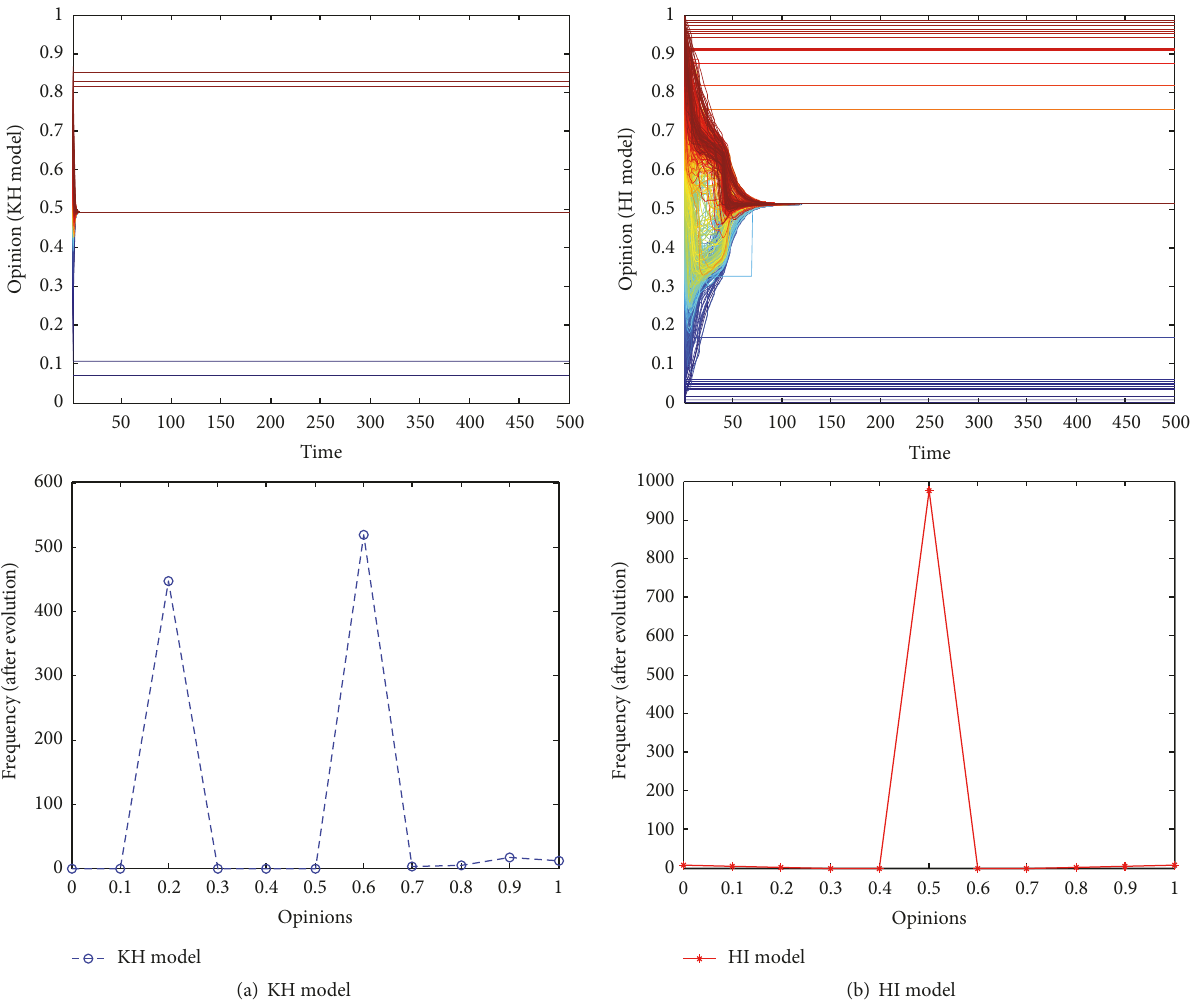
Figure 7: The opinion evolution in scale-free network. (a) KH model and (b) HI model. 𝜀 = 0.2, 𝛿 = 400